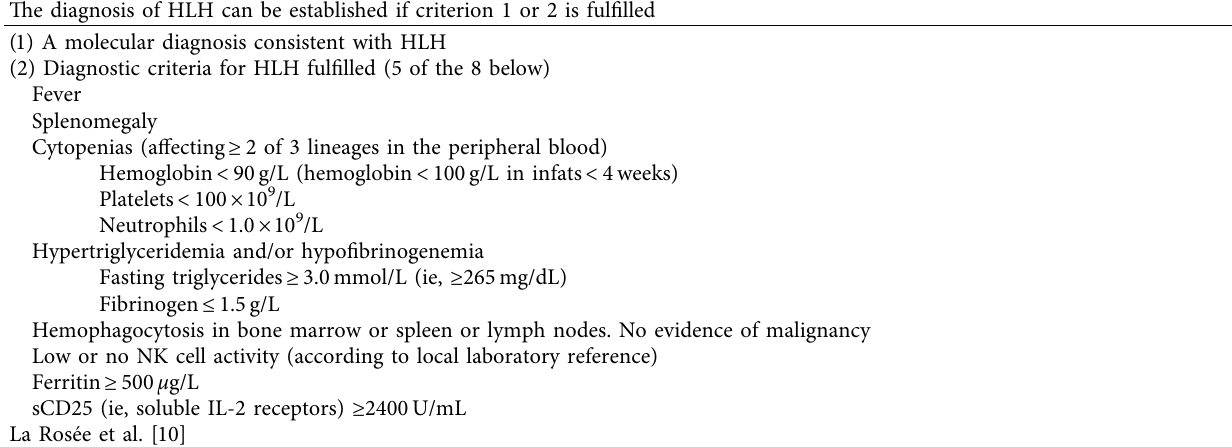
Table 1: HLH-2004 diagnostic